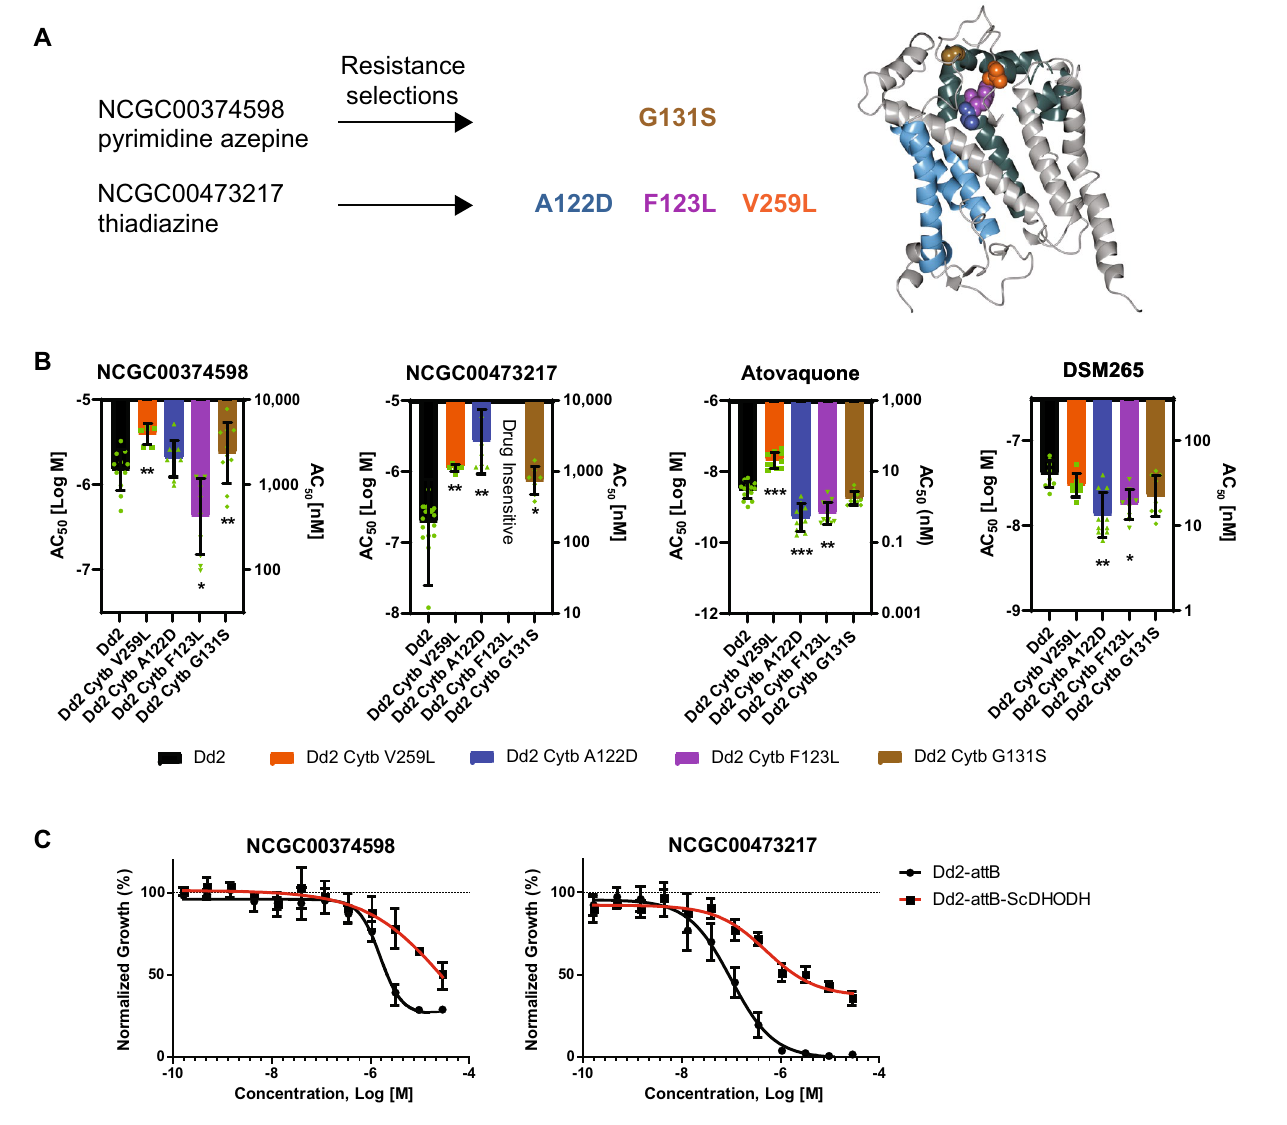
Figure 4. Resistance to pyrimidine azepine and thiadiazine hit compounds results in mutations in P.